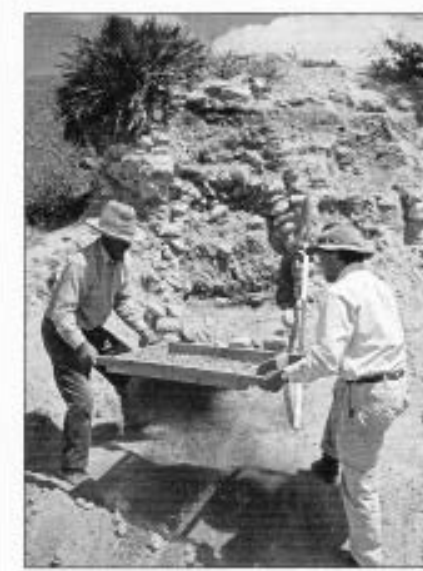
Figure 5 Dorian Fuller (right) and a col­ league dry-sieving the contents of a medi­ eval storage pit at Volubilis, also sampled for archaeobotanical evidence.